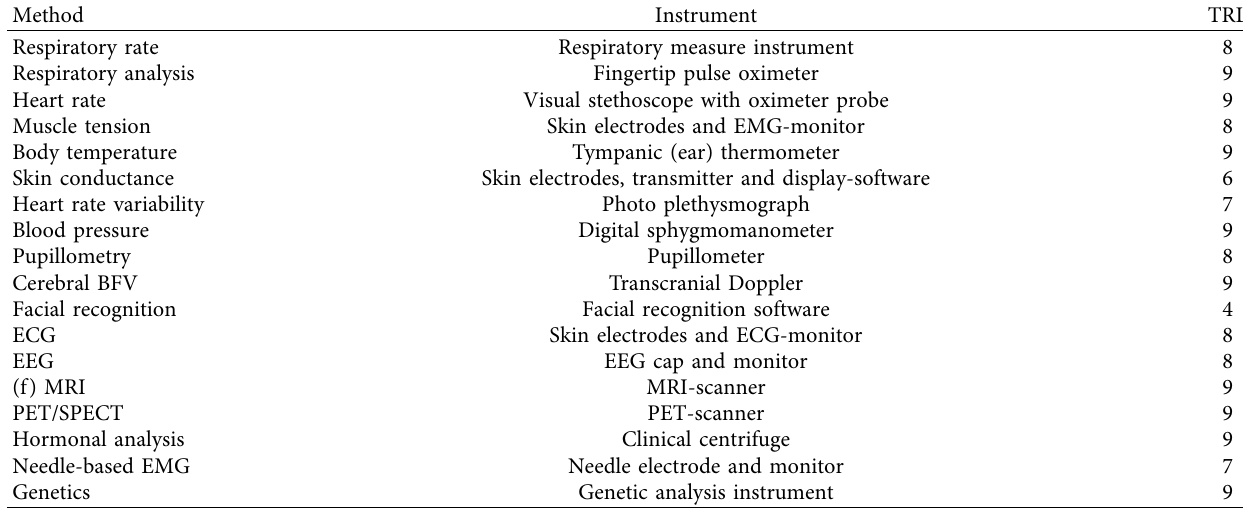
Table 5: Technology readiness levels (TRLs) determined for one technological instrument (most used or most described) per detection method, ordered according to